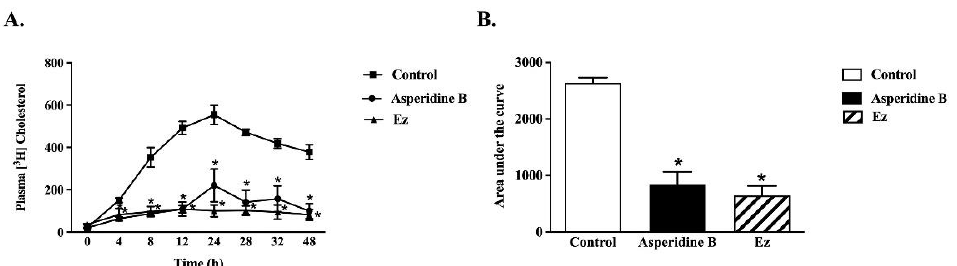
Figure 6. Effect of asperidine B or ezetimibe on plasma [ 3 H]-cholesterol in rats. ( A ) The plasma [ 3 H] cholesterol level was measured at 0, 4, 8, 12, 24, 32, and 48 h after oral administration with [ 3 H]cho- lesterol (10 µCi/mL), with or without 31.75 µg/kg BW asperidine B or 10 mg/kg BW ezetimibe. ( B ) The total area under the curve from ( A ) was analyzed. Values are mean ± SEM ( n = 4 − 6), * p < 0.05 vs. control.